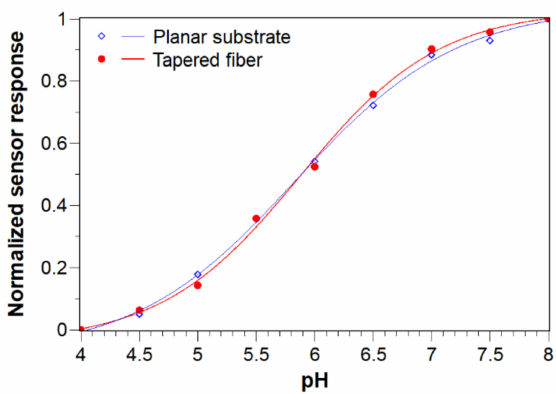
Figure 6. Normalized calibration curves measured on a planar substrate with fluorescence spectrom- eter (blue diamonds) and on a tapered fiber-optic probe with the sensor system (red dots).